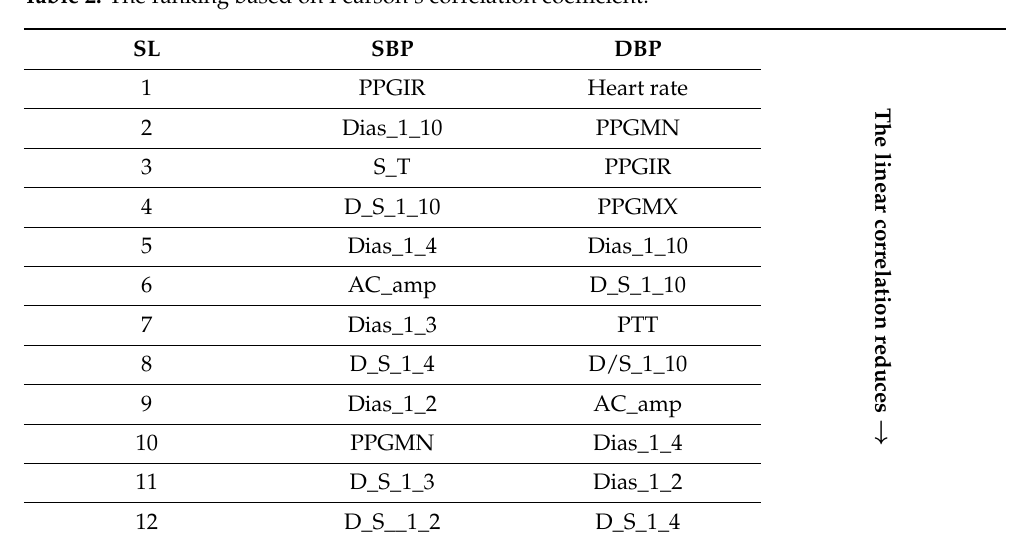
Table 2. The ranking based on Pearson’s correlation